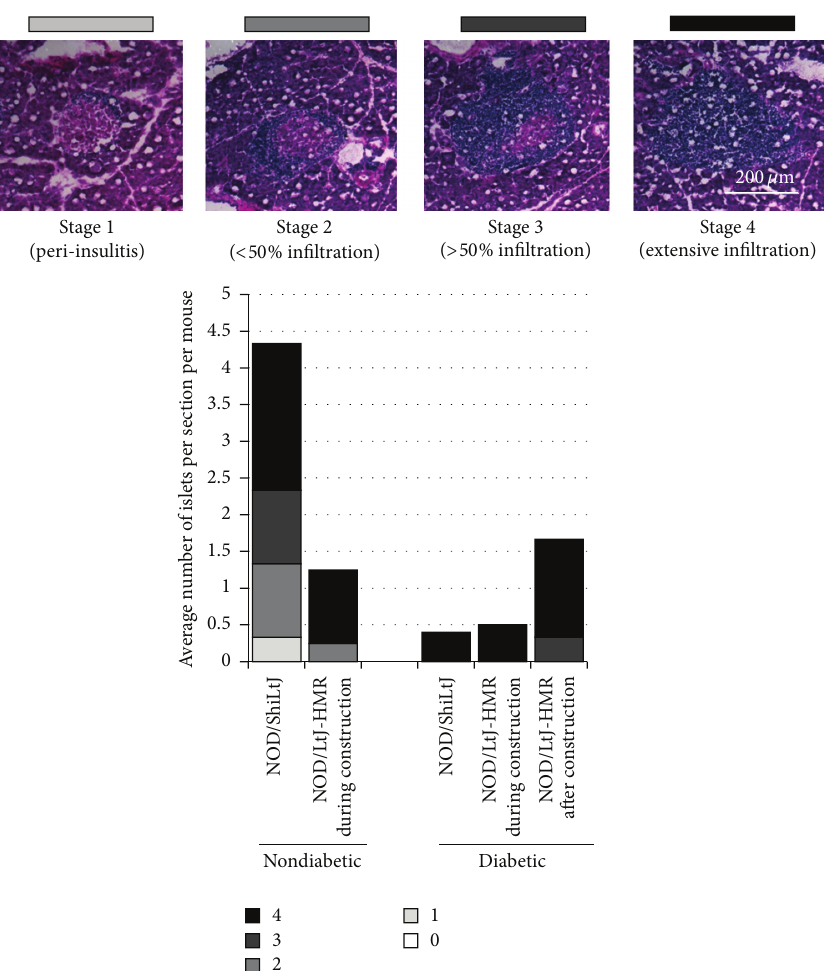
Figure 4: Islet destruction and lymphocytic infiltration in nondiabetic NOD mice subject to construction stress. The number of islets per pancreatic section was scored as exemplified by the histology sections presented (scale 200 𝜇 m). At least three mice per group were included except for the diabetic NOD/LtJ-HMR mice during construction, which included only two mice. Note that there are no nondiabetic mice from the NOD/LtJ-HMR mice born after